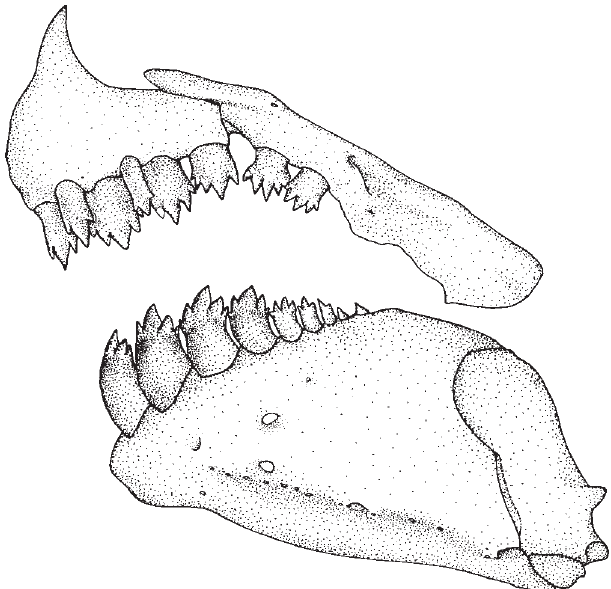
Fig. 9. Bryconadenos tanaothoros , new species, USNM 352061, paratype, SL 33.7 mm, adult male. Jaws and dentition lateral view, left side. Brazil: Mato Grosso: tributary to rio Suiazinho, near Ribeirão